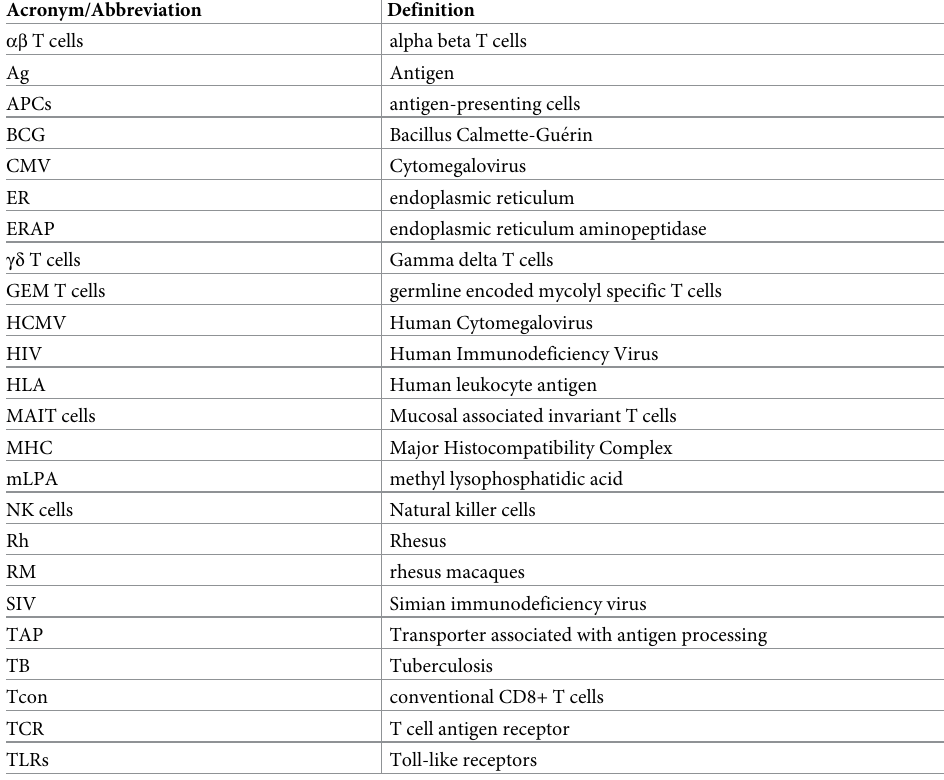
Table 1. Acronyms and